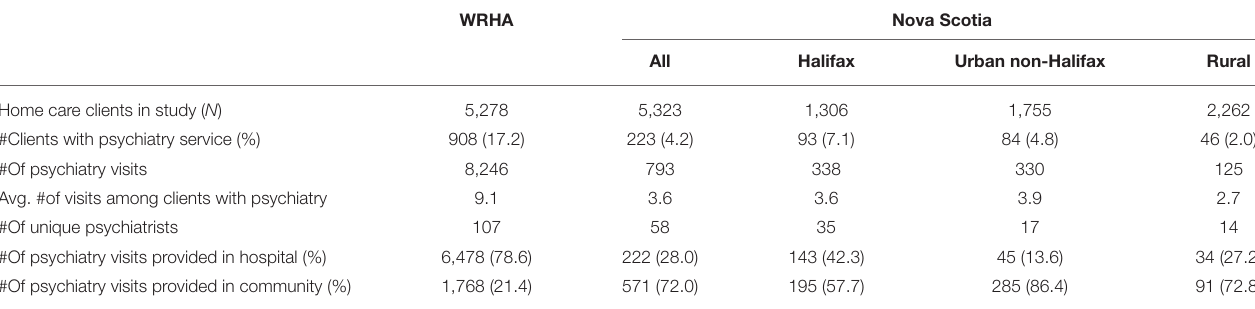
TABLE 1 | Psychiatry services, by province, and